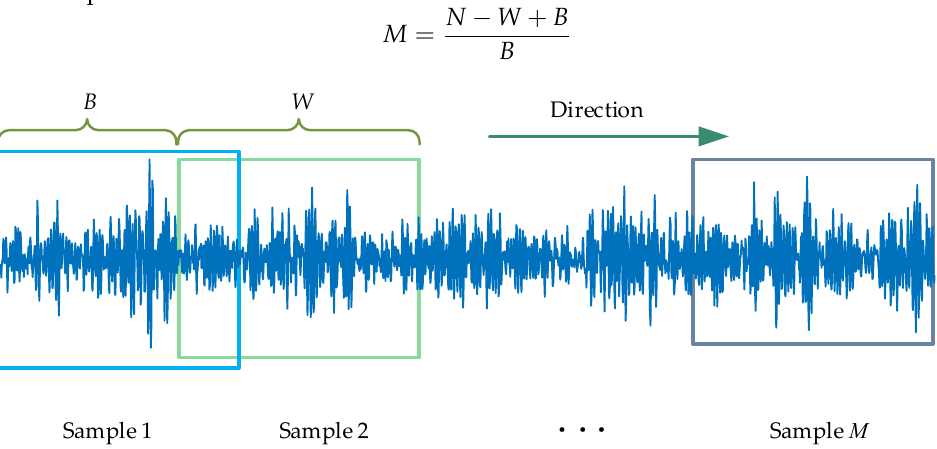
Figure 1. Illustration of the sliding segmentation. It mainly contains four key factors, including window size, sliding step and starting point, and sliding direction.